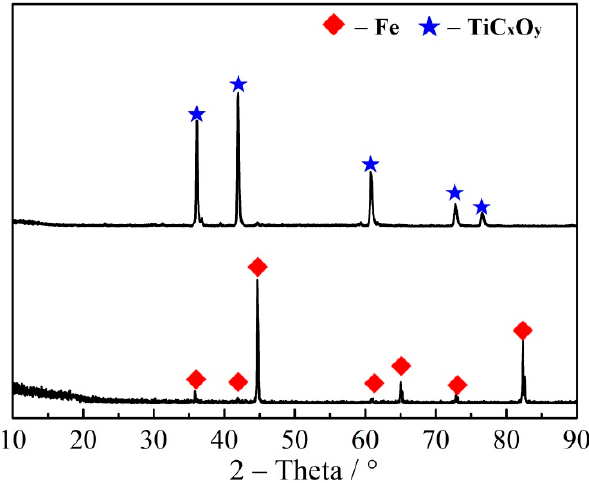
Figure 13. XRD patterns of iron and floated